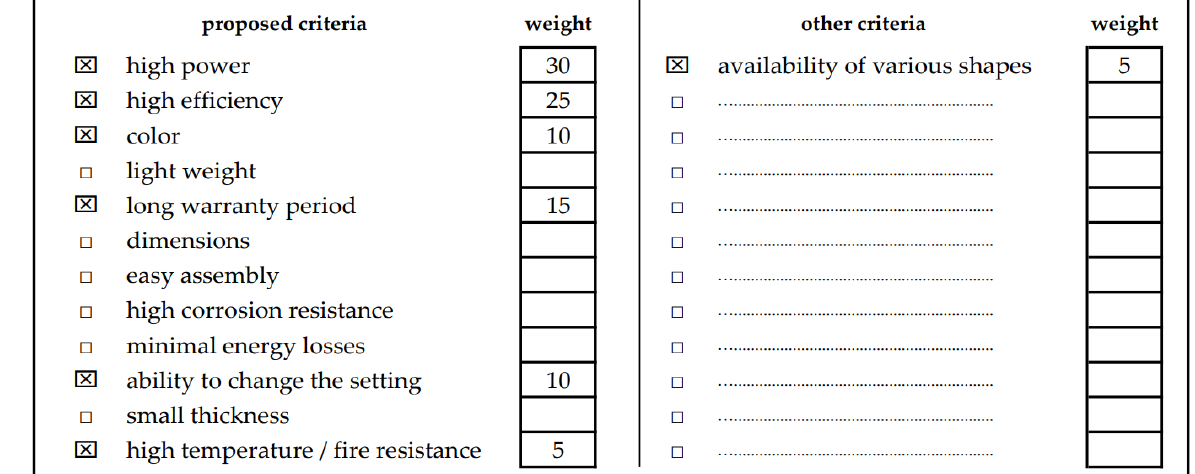
Figure 6. Questionnaire with obtained customer expectations about photovoltaic panels criteria. Own study.